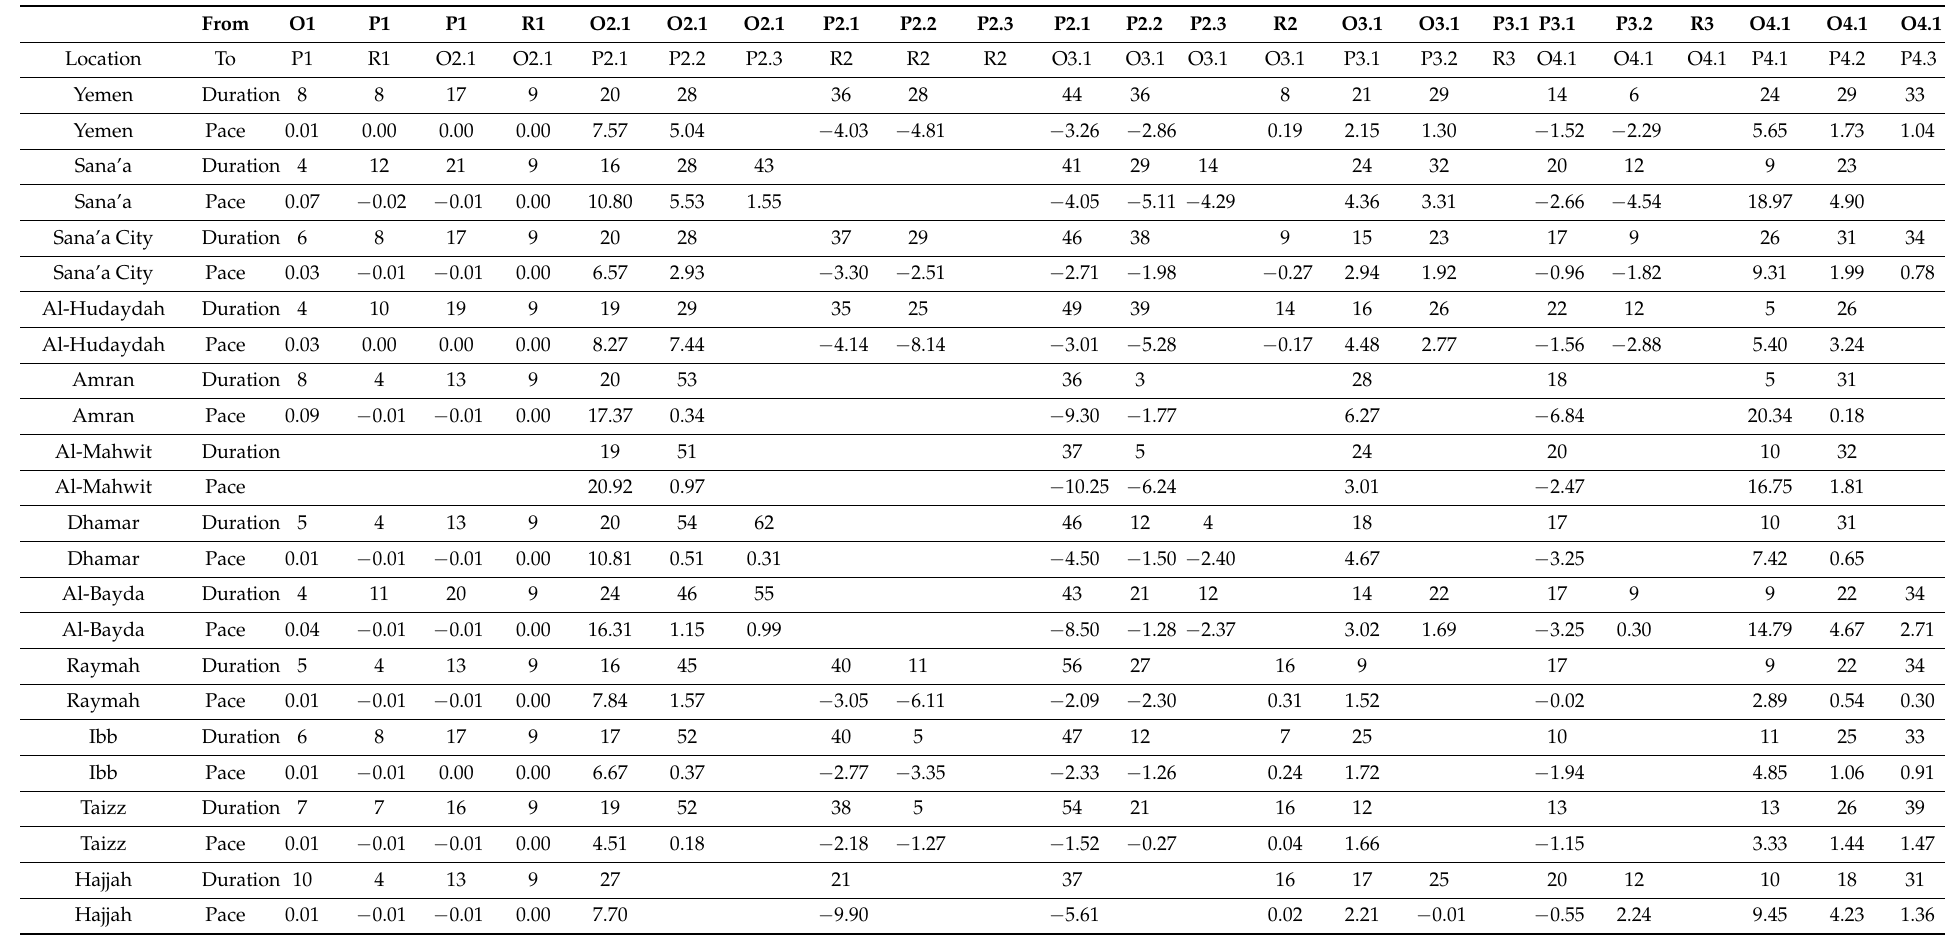
Table 2. Summary of the acceleration, deceleration, and steady-state critical period durations and the pace of increase and decline for four outbreak waves in